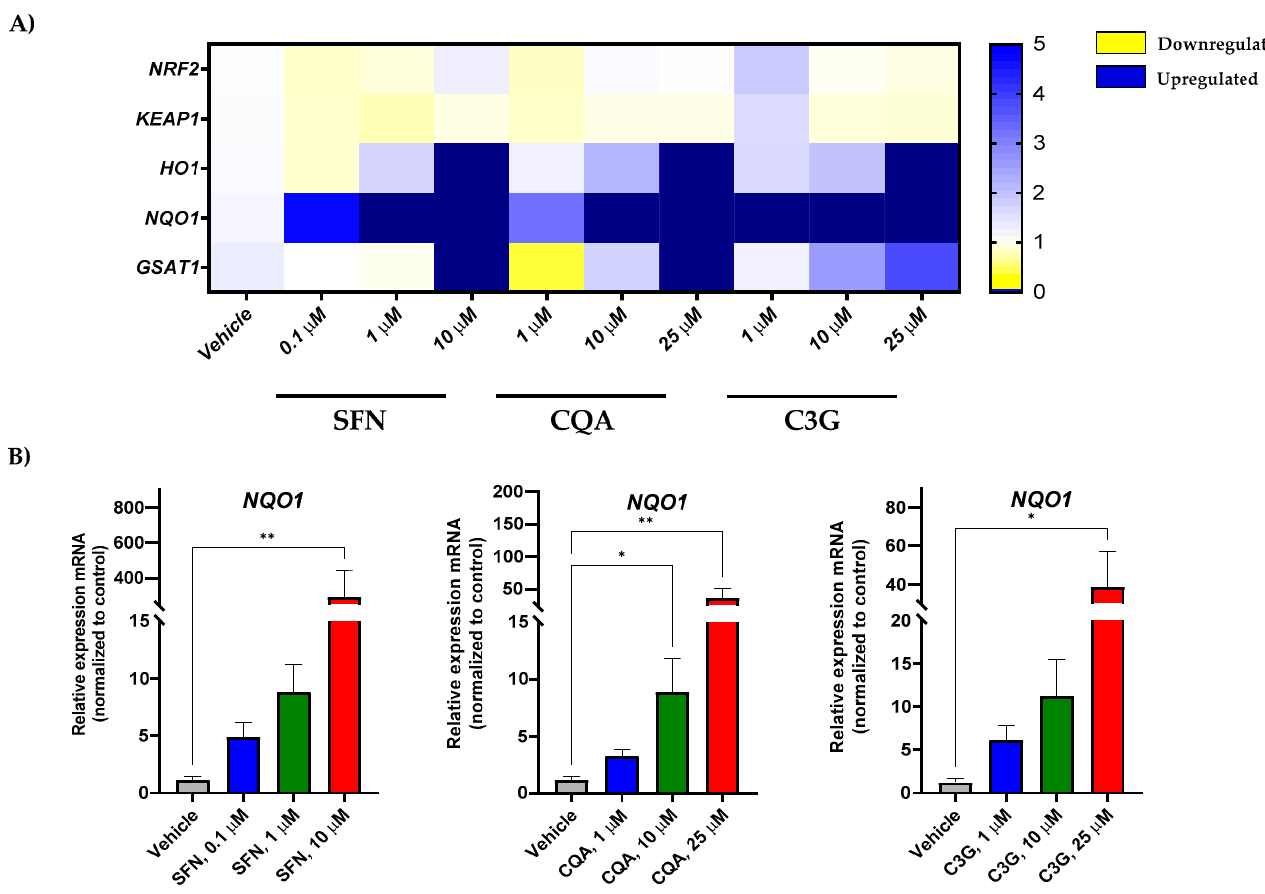
Figure 3. Brassica spp. phytochemicals modulate gene expression levels of Nrf2-target genes in the undifferentiated HL-60 cell line. ( A ) Human acute myeloid leukemia cell line HL-60 gene expression profile in response to SFN, CQA, and C3G exposure at different concentrations by qRT- PCR. Represented as the fold change between condition and the vehicle group. Values outside the range represented in dark blue; ( B ) Significant changes in oxidative stress genes by RT-qPCR. All values are represented as the fold change of relative RNA expression between the condition and the vehicle group. Statistical analyses were performed using Kruskal- Kruskal–Wallis one-way analysis of variance and Dunn’s post hoc analysis. All values are given as mean ± SD. * p < 0.05, ** p < 0.01. SFN, sulforaphane; CQA, Chlorogenic acid; C3G, cyanidin-3-glucoside chloride; I3C, indole-3-car-